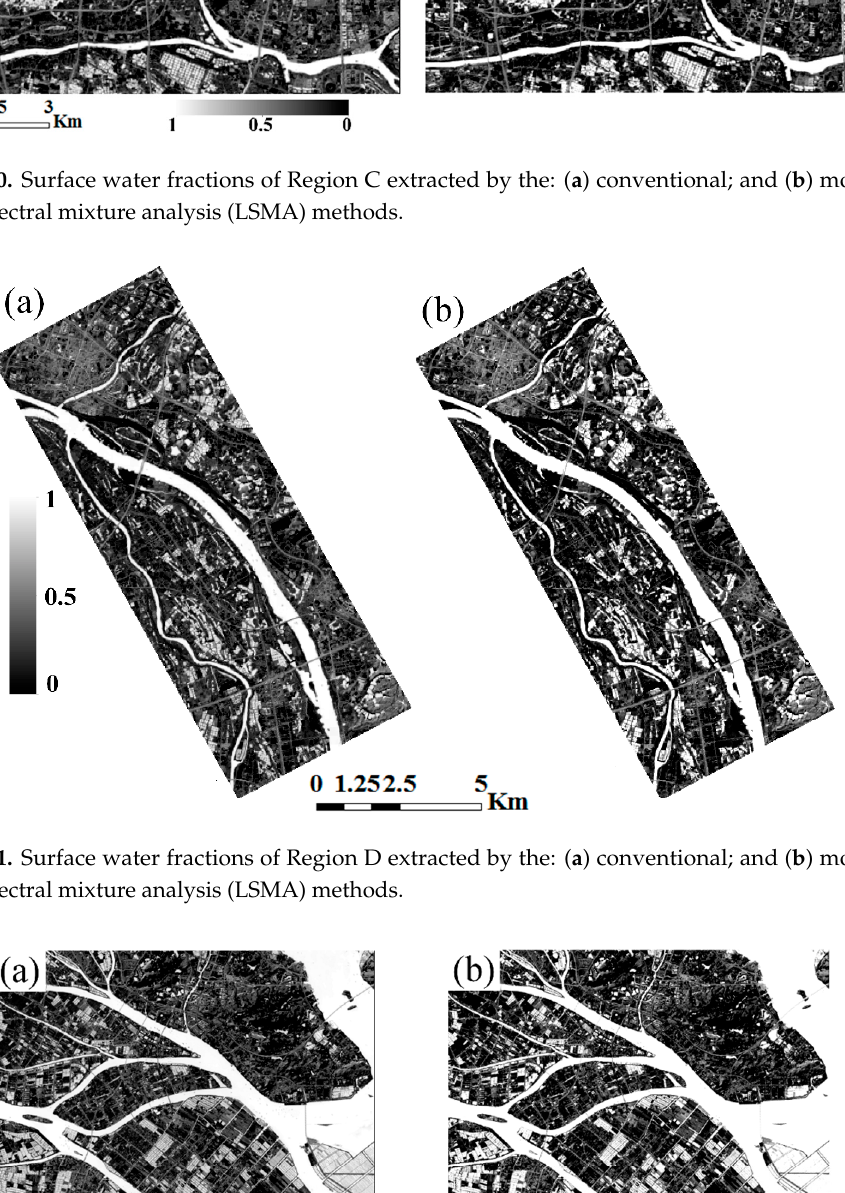
Figure 10. Surface water fractions of Region C extracted by the: ( a ) conventional; and ( b ) modified